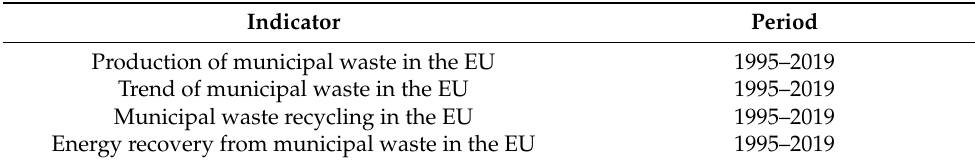
Table 1. Structure of data collected.